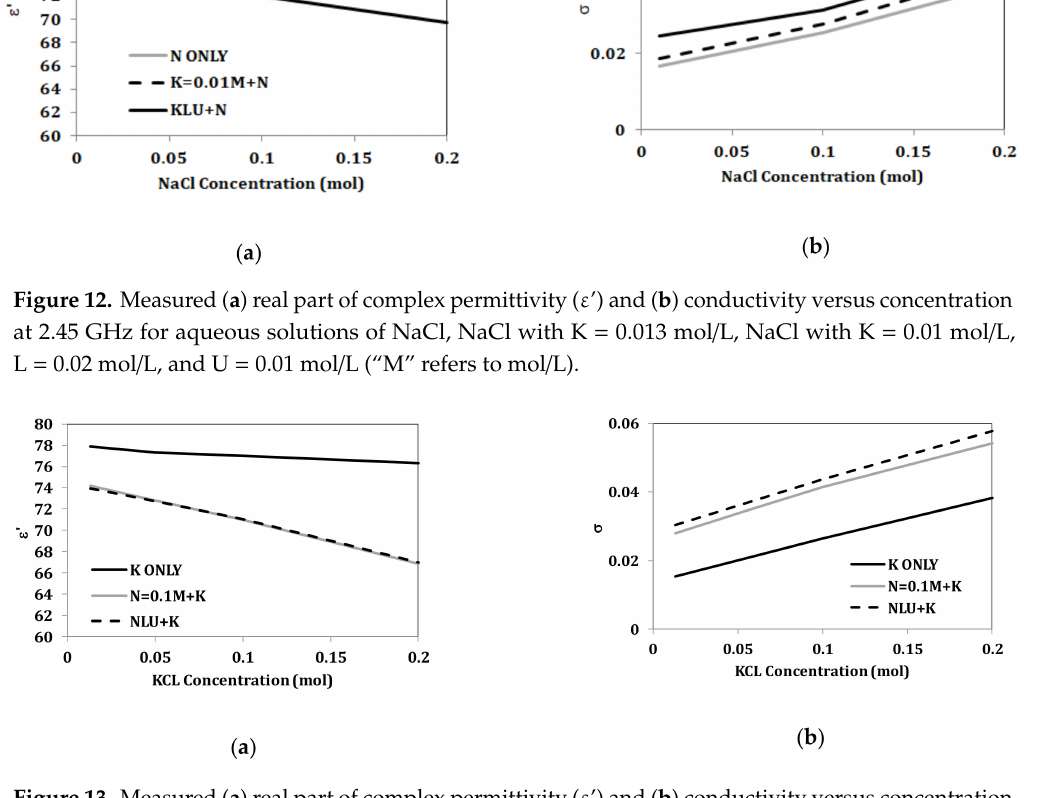
Figure 13. Measured ( a ) real part of complex permittivity ( ε ’) and ( b ) conductivity versus concentration at 2.45 GHz for aqueous solutions of KCl, KCl with N = 0.1 mol / L, KCl with N = 0.1 mol / L, L = 0.02 mol / L, and U = 0.01 mol / L (“M” refers to mol /